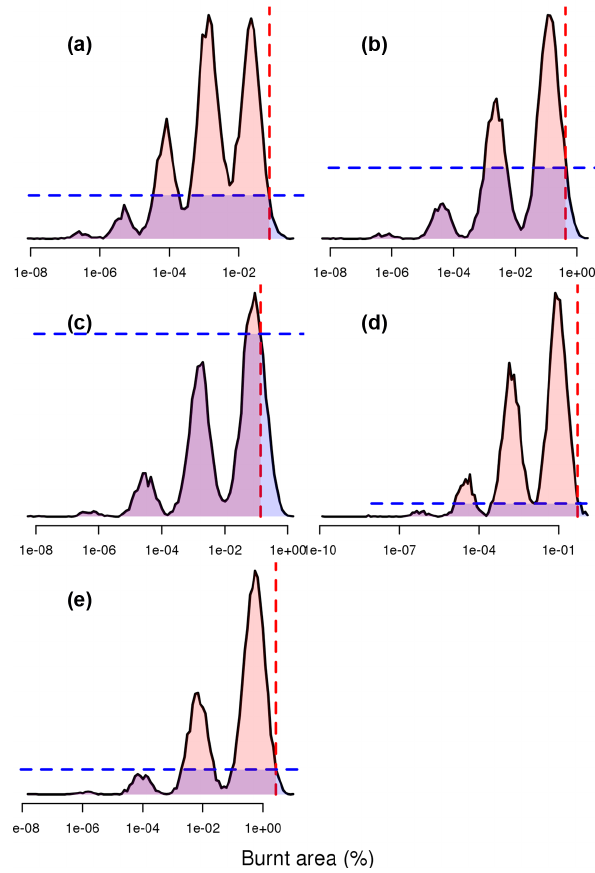
Figure B2. As Fig. B1 but for August